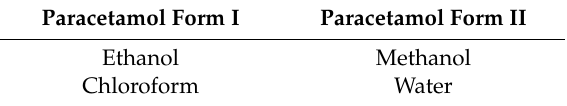
Table 3. Polymorphs of paracetamol obtained from di ff erent solvents (experimental).